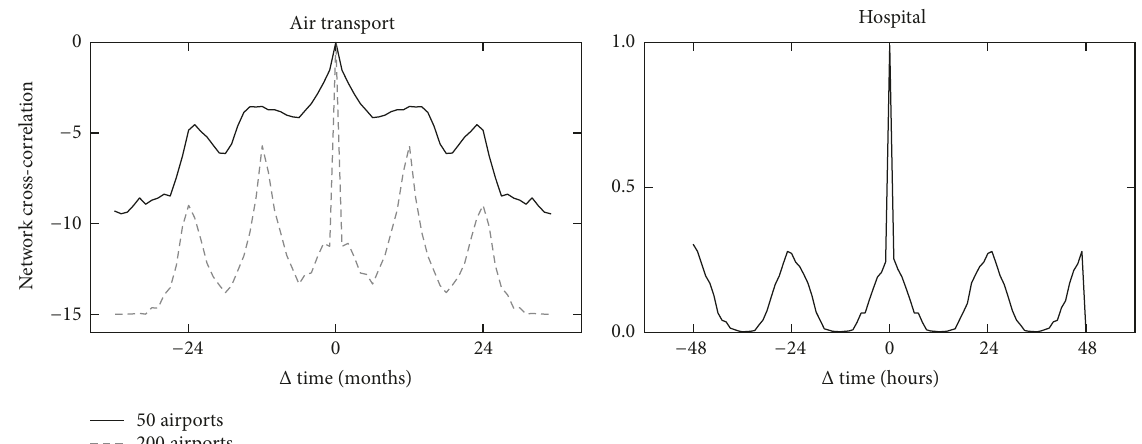
Figure 7: Correlograms for the air transport (left panel) and hospital networks (right panel). While the Y axis of both panels represents the same concept, the specific measure changes: the log 10 of the 𝑝 -value of 𝐼𝐶 † in the former case and 𝐼𝐶 ∗ in the latter. See main text for